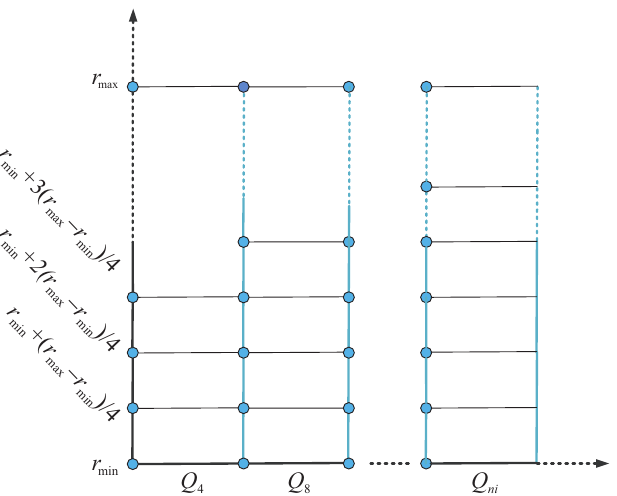
Fig. 2 The r min and r max components belong to every set Q , Q includes the i division